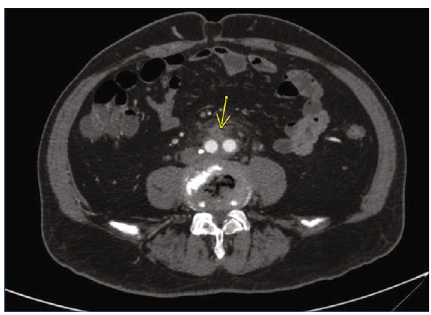
Figure 2: Extension of in fl ammation distally in both limbs of